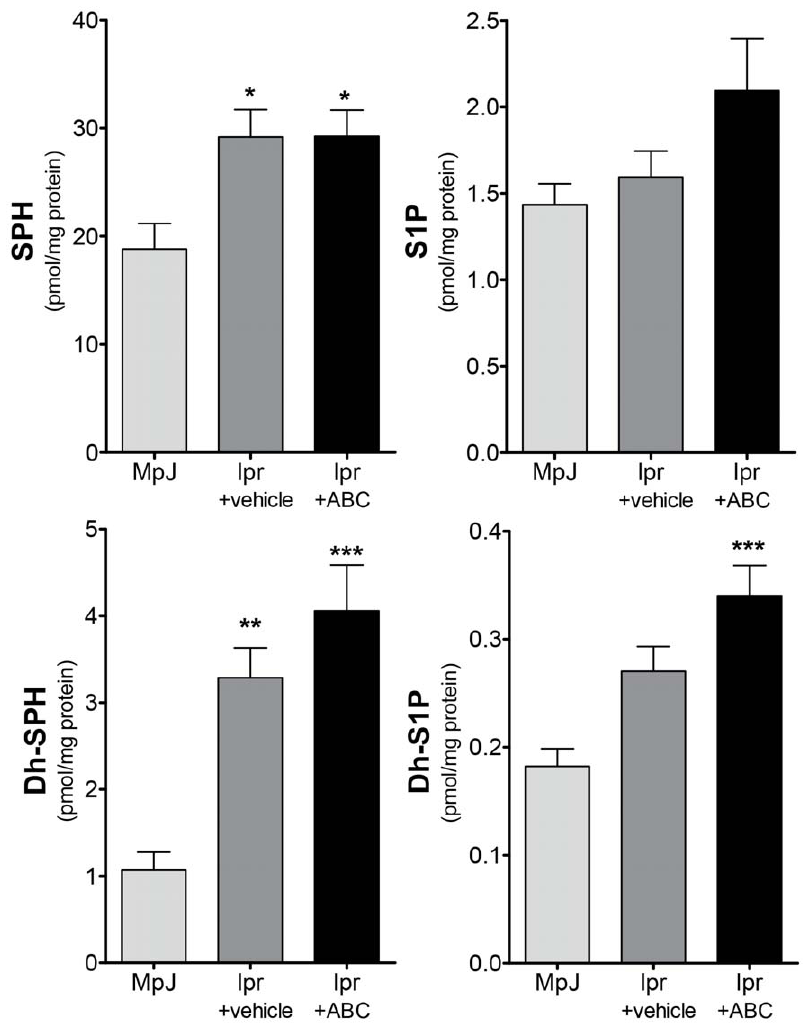
Figure 7. Increase in kidney Dh-S1P is not prevented by ABC294640 in lupus mice. After 10 weeks of ABC294640 or vehicle administration, kidneys were collected from MRL/MpJ or MLR/lpr mice. Kidney tissue was homogenized and analyzed for sphingolipid content by the Lipidomics Shared Resource at MUSC, A ) sphingosine, B ) S1P, C ) Dh-sphingosine and D ) Dh-S1P. Data represent mean 6 SEM, n $ 10; *p , 0.05, **p , 0.01, ***p , 0.001 treated vs.